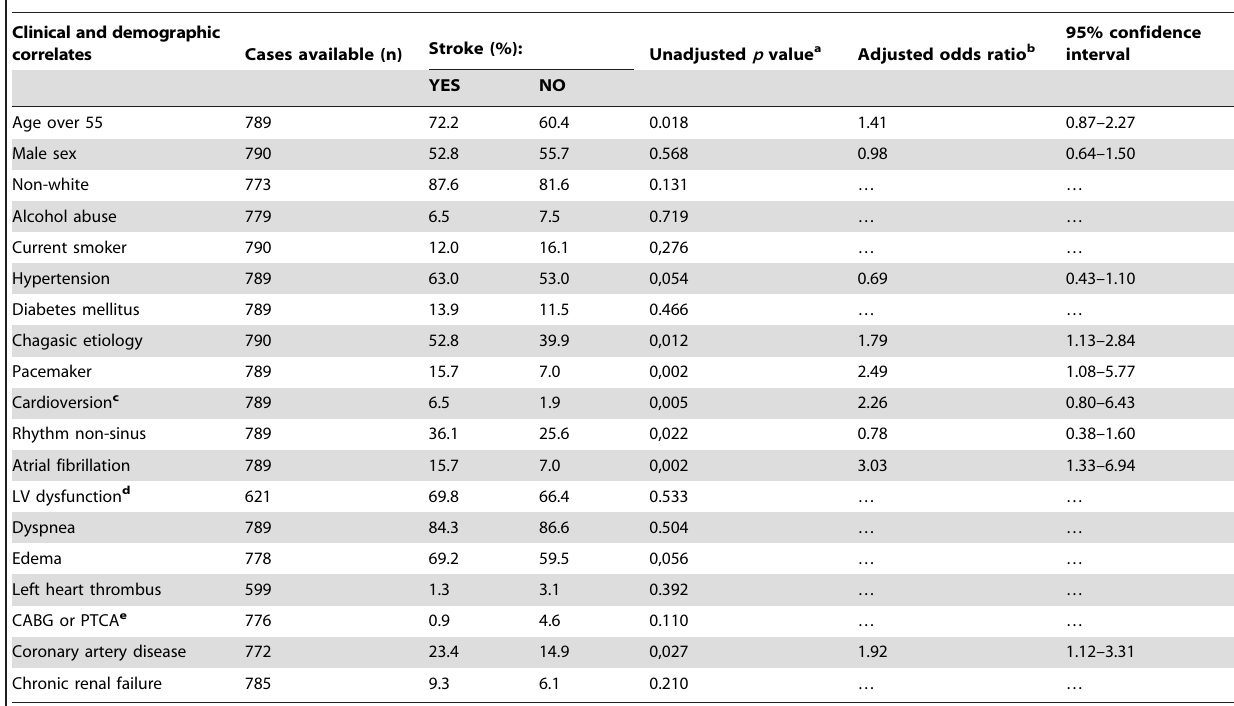
Table 2. Clinical and Demographic Correlates of Stroke in 790 Cardiomyopathy Patients.